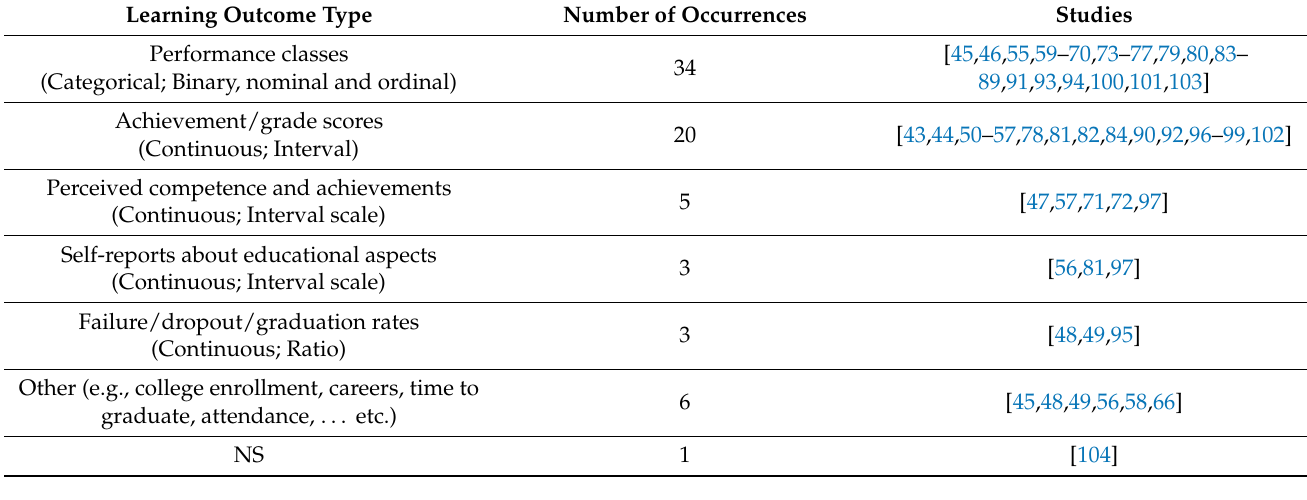
Table 6. Distribution of studies based on the type of learning outcomes predicted.